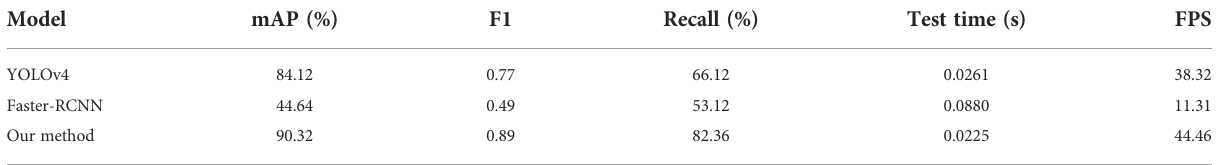
TABLE 5 Recognition effects of different advanced target detection models.